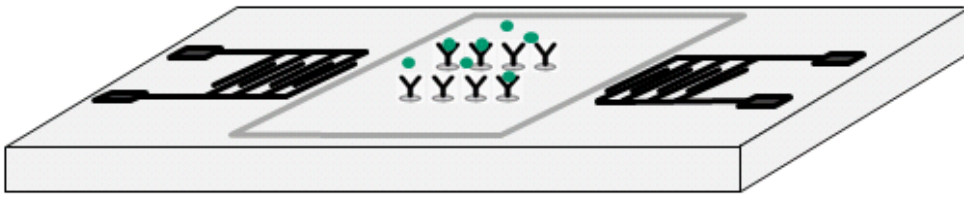
Figure 1. Illustration of the